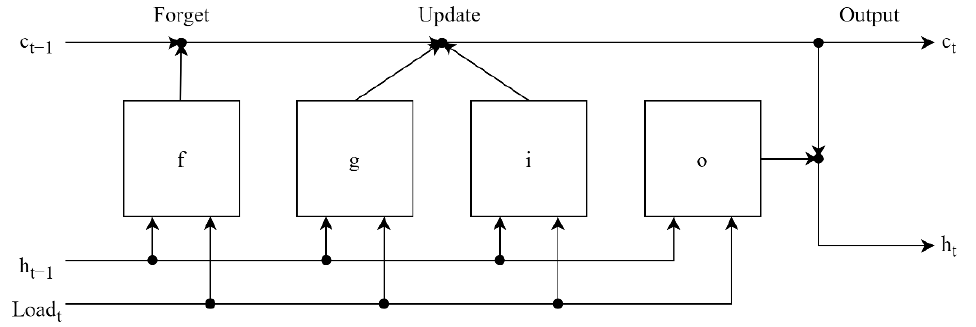
Figure 5. Functions of LSTM block’s gate.